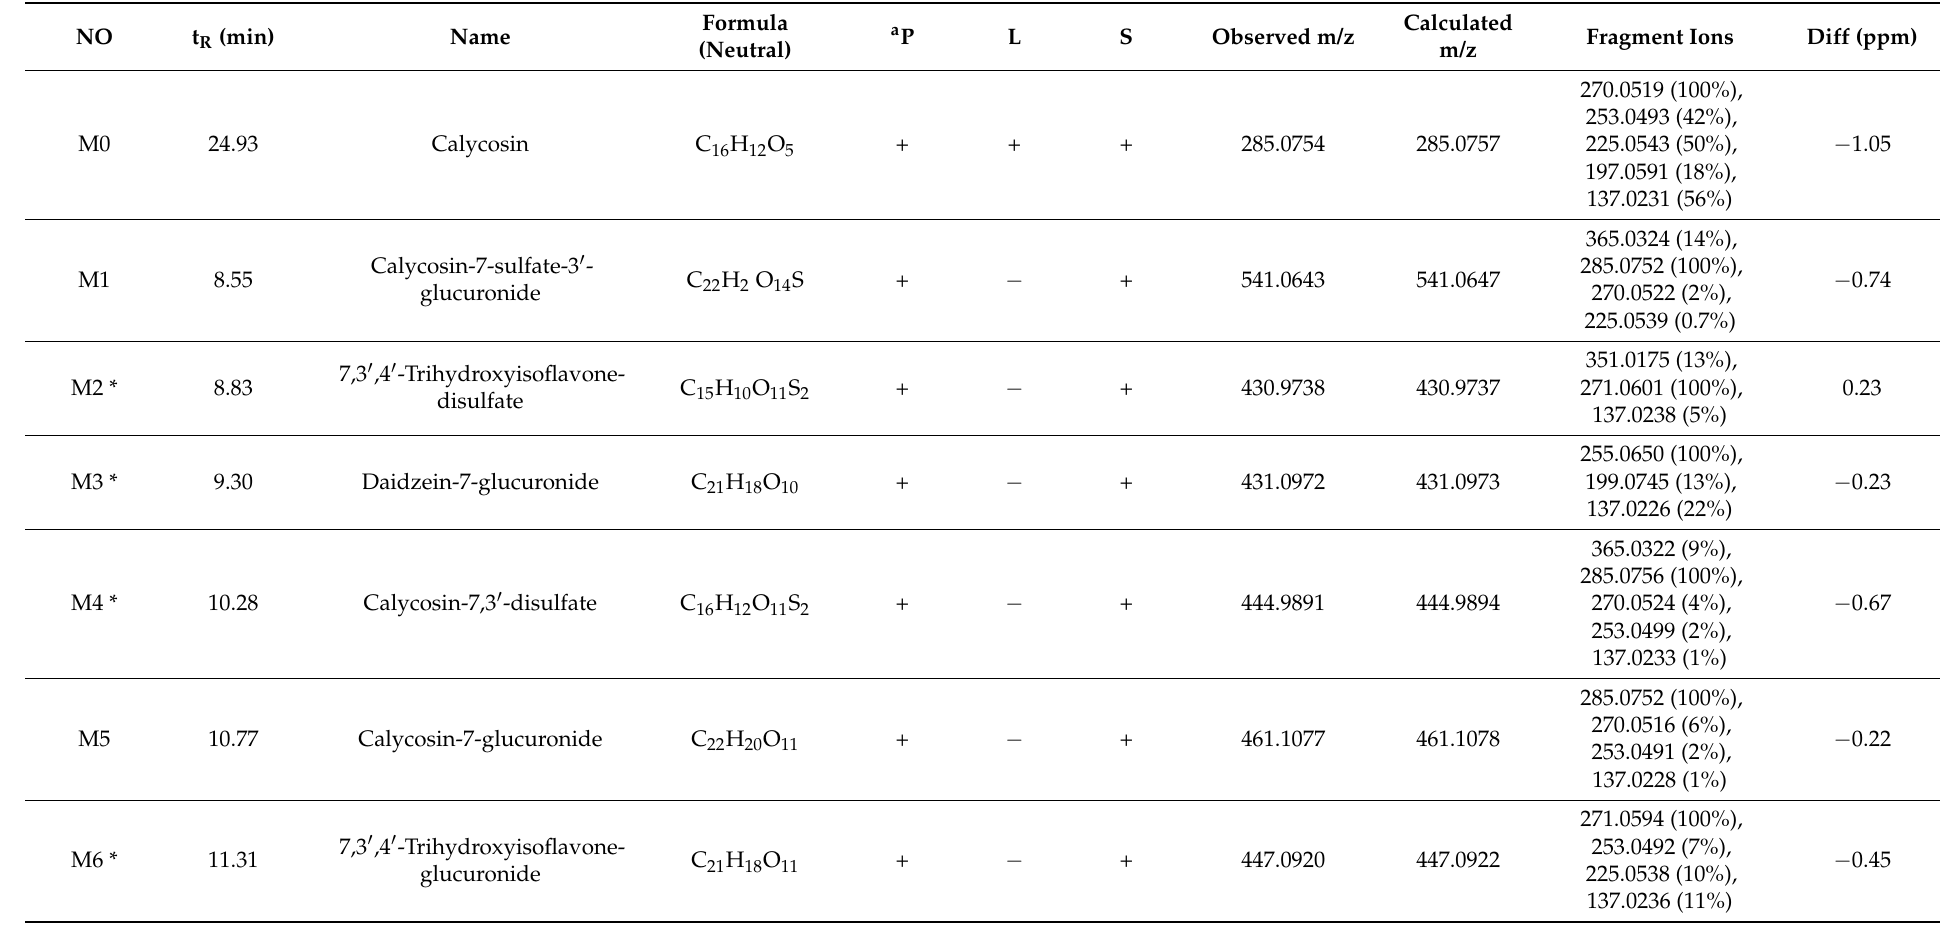
Table 1. Summary of the mass spectral data of calycosin and its metabolites detected in the biological samples of